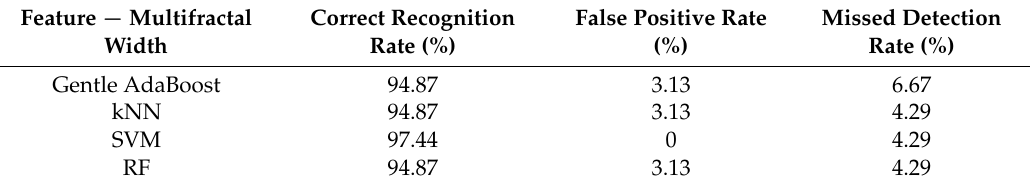
Table 4. Experimental results of constructing different recognition models based on multifractal width.